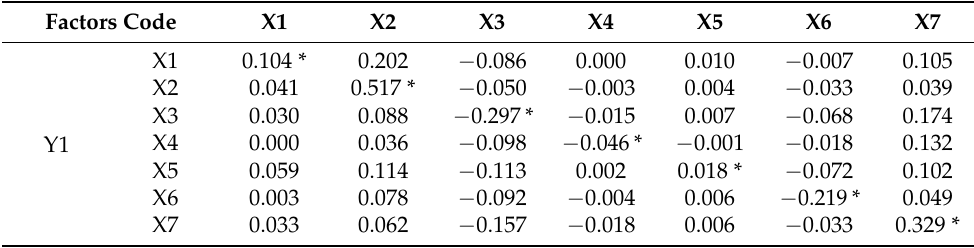
Table A2. Path coefficients between soil nutrients factors (X) and soil enzyme activity (Y) in in CPM. Factors